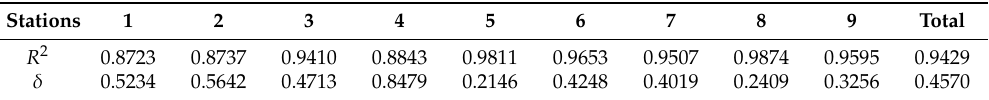
Table 5. The R 2 and δ of the analytical model compared with the lidar measurement in different turbidities.